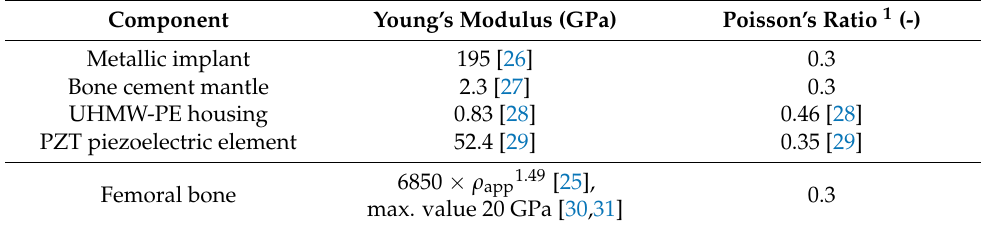
Table 1. Material properties of the defined components in the finite element model. Component Young’s Modulus (GPa) Poisson’s Ratio 1 (-) Metallic implant 195 [26] 0.3 Bone cement mantle 2.3 [27] 0.3 UHMW-PE housing 0.83 [28] 0.46 [28] PZT piezoelectric element 52.4 [29] 0.35 [29] 6850 × ρ app1.49 [25], Femoral bone max. value 20 GPa [30,31]